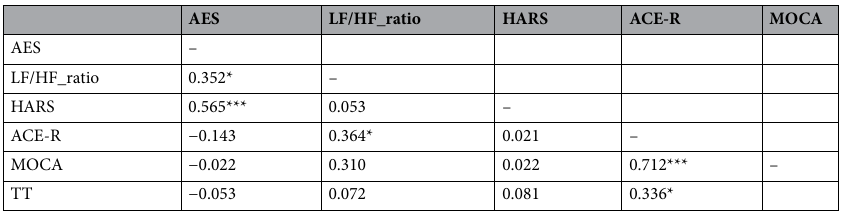
Table 4. Correlation Matrix—during pandemic. AES Apathy Evaluation Scale, LF/HF low-frequency/high- frequency ratio, HARS Hamilton Rating Scale for Anxiety, ACE-R Addenbrooke’s cognitive examination—